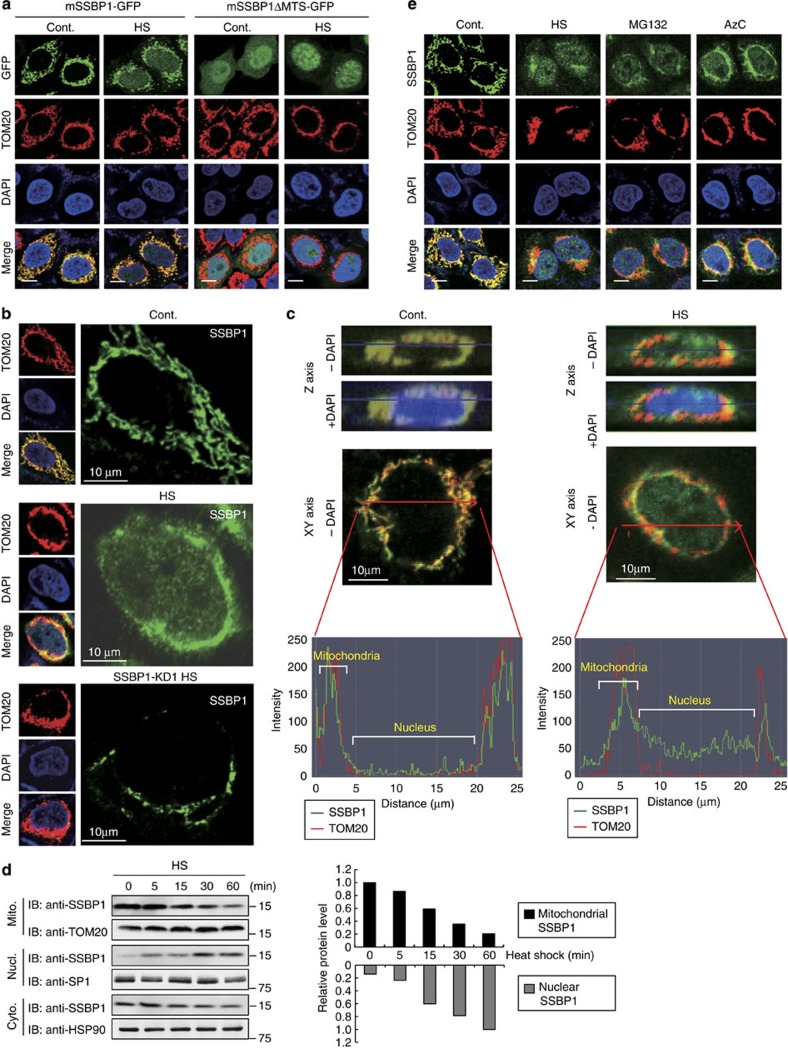
Mitochondrial SSBP1 translocates to the nucleus during heat shock.(a) GFP-fused mSSBP1 can accumulate in the nucleus. HeLa cells were transfected with an expression vector for mSSBP1-GFP or mSSBP1ΔMTS-GFP for 48 h, and were treated without (Cont.) or with heat shock at 42 °C for 60 min (HS). They were co-stained with antibody for the mitochondrial marker TOM20, and the nuclear marker DAPI. Each fluorescence image of GFP (green), TOM20 (red) or DAPI (blue) was obtained by scanning confocal microscopy, and merged images (Merge) are shown. Scale bars, 10 μm. (b) Nuclear localization of SSBP1 in heat-shocked cells. HeLa cells were treated without (Cont.) or with heat shock at 42 °C for 60 min (HS), and co-stained with antibodies for SSBP1 and TOM20, and DAPI. Each fluorescence image of SSBP1 (green), TOM20 (red) or DAPI (blue) was obtained by scanning confocal microscopy, and merged images (Merge) are shown. Scale bars, 10 μm. Alternatively, HeLa cells were infected with Ad-sh-hSSBP1-KD1 for 72 h, treated with heat shock (SSBP1-KD HS) and co-stained as described above (bottom). (c) HeLa cells were treated, co-stained as described in b. The fluorescence intensities (arbitrary unit) at the lane (red line) in each cell are shown. (d) HeLa cells were treated with heat shock at 42 °C for the indicated periods. Cytoplasmic (Cyto.), nuclear (Nucl.) and mitochondrial (Mito.) fractions were prepared as described in Methods. Equivalent volumes of the fractions were subjected to western blotting using antibody for SSBP1, TOM20, SP1 and HSP90 (left). The signals were estimated using ImageJ, and relative protein levels compared with a control level or that after heat shock were shown (right). (e) SSBP1 translocates to the nucleus in response to proteotoxic stresses. HeLa cells were treated without (Cont.) or with heat shock at 42 °C for 60 min (HS), a proteasome inhibitor MG132 (10 μM) for 3 h, or a proline analogue, L-azetidine-2-carboxylic acid (5 mM) for 6 h (AzC). The cells were co-stained as described in b. Bars, 10 μm.